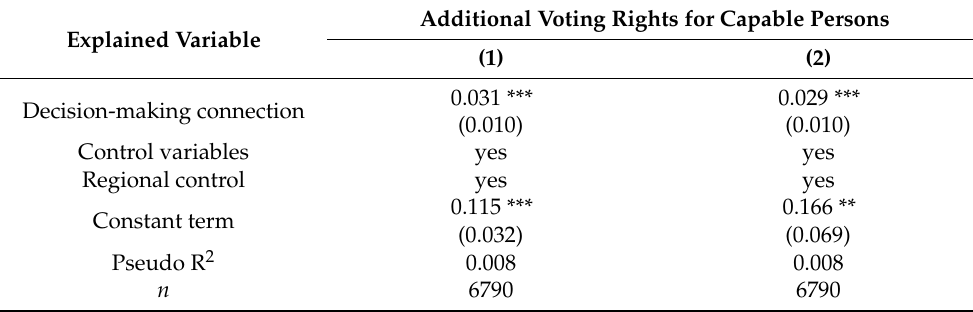
Table 6. Mitigation mechanisms of decision-making connection on rights poverty of farmers. Explained